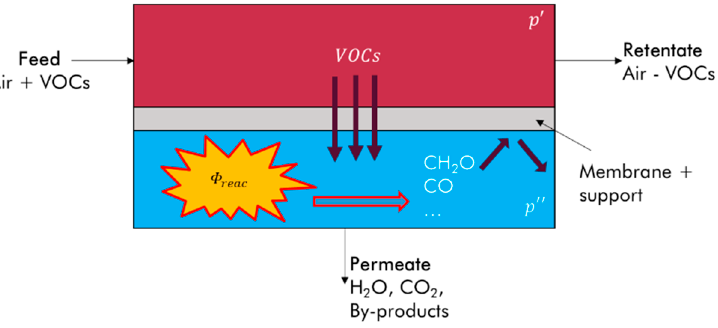
Figure 1. Figure 1. Principle of coupling of VOC permeation and photocatalytic reaction on the permeate compartment.